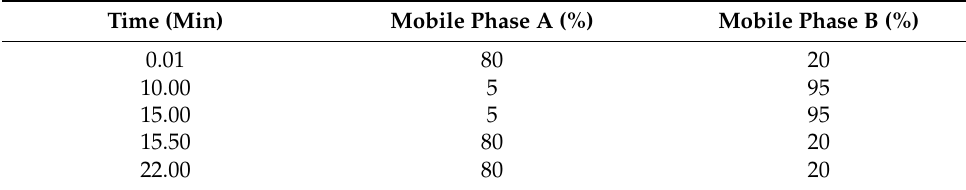
Table 5. Gradient of mobile phases over time.